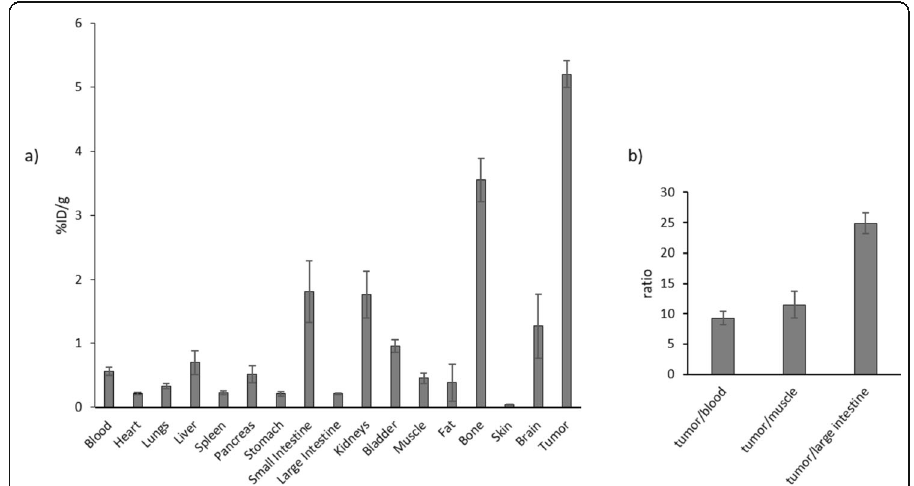
Fig. 8 a ) Ex vivo biodistribution of [ 68 Ga]Ga-DOTA.SA.FAPi in HT-29 xenograft mice ( n = 3) 1 h p.i. b ) Tumor- to-organ ratios of [ 68 Ga]Ga-DOTA.SA.FAPi in HT-29 xenograft mice ( n = 3) 1 h